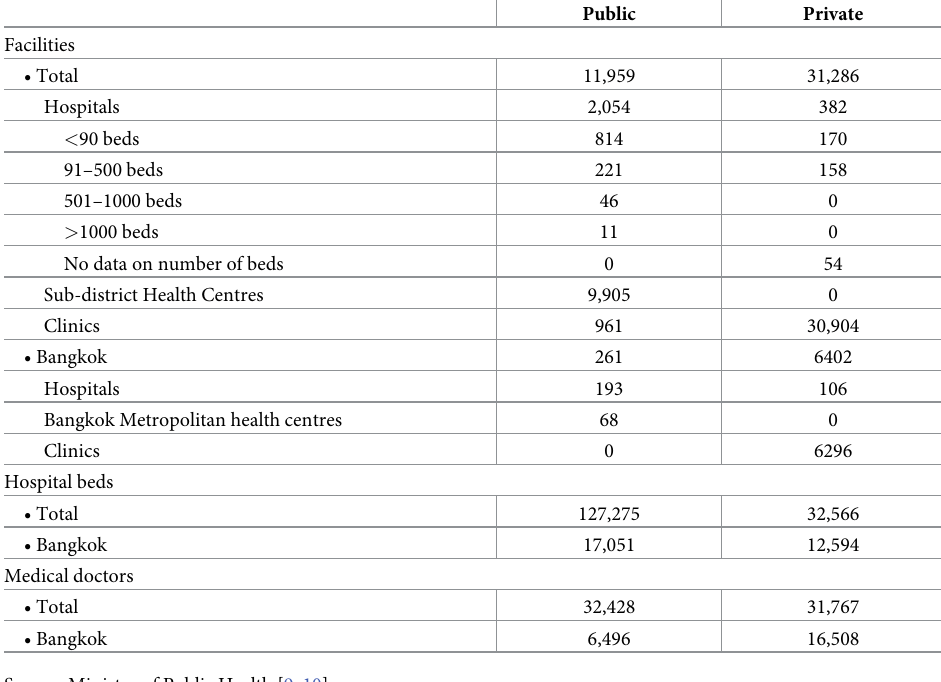
Table 1. Numbers of health facilities, hospital beds and medical doctors in the public and private sectors catego- rized by facility types and geographic